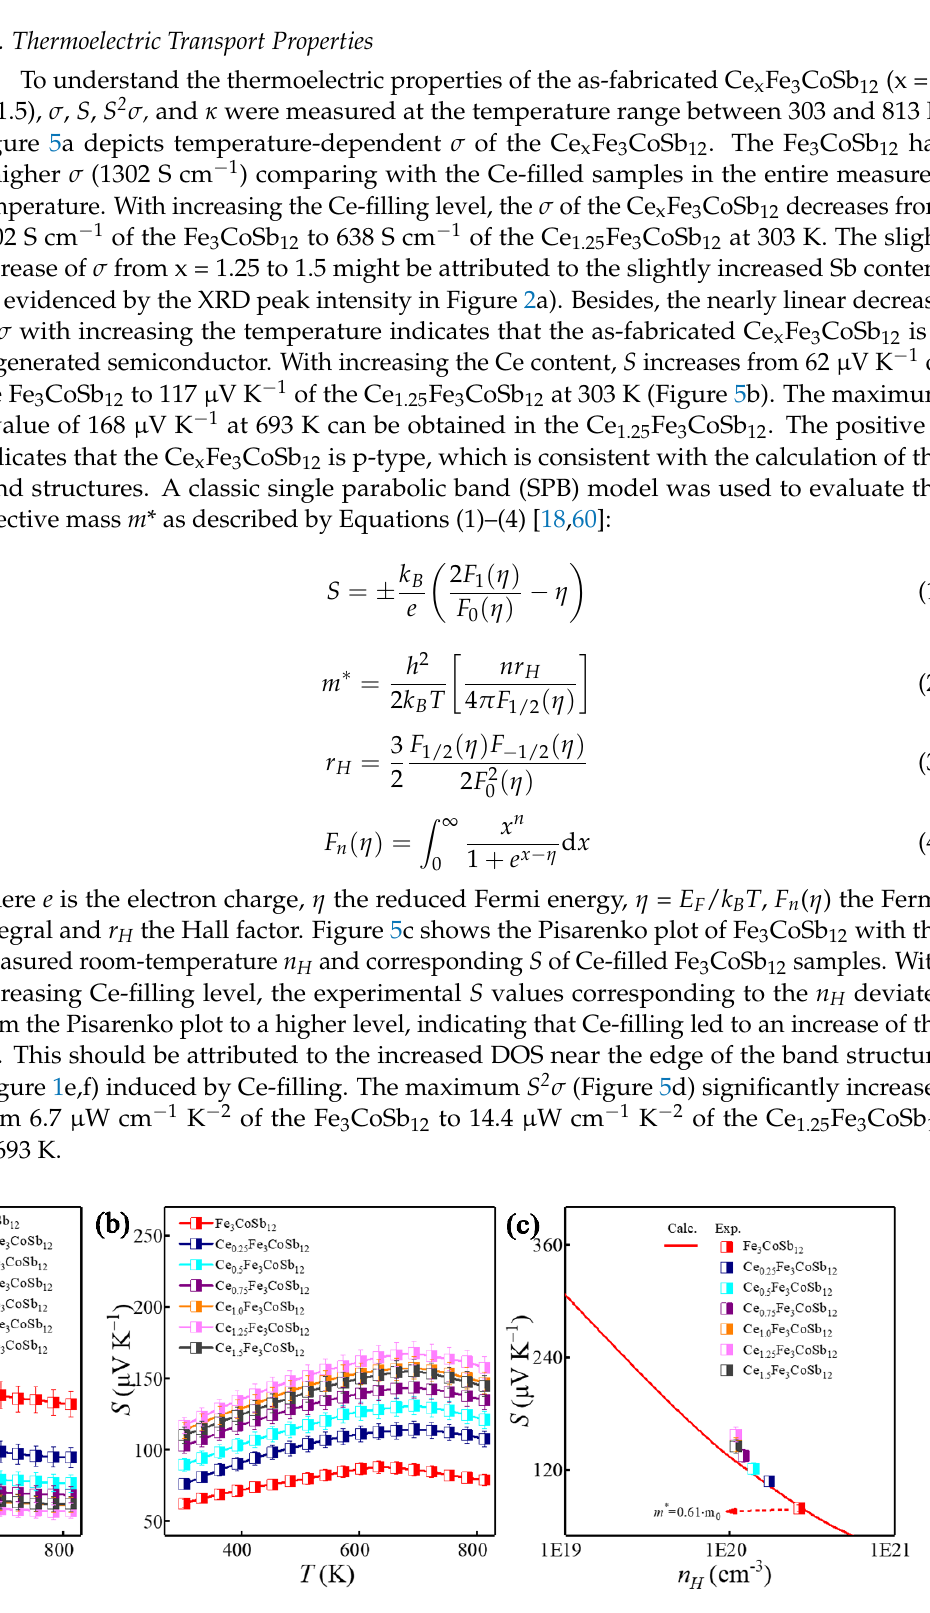
Figure 5. Thermoelectric properties of Ce x Fe 3 CoSb 12 (x = 0 to 1.5). Temperature-dependent ( a ) σ ; ( b ) S . ( c ) The experimental S values corresponding to the n H , where the red line represents the Pisarenko plot for Fe 3 CoSb 12 . Temperature-dependent ( d ) S 2 σ ; ( e ) κ ; ( f ) κ e ; ( g ) κ l ; ( h ) zT . ( i ) Comparison of the room-temperature κ for nominal Ce 1.25 Fe 3 CoSb 12 with the reported values for CeFe 2 Co 2 Sb 12 prepared by AM, [59] CeFe 4 Sb 12 [61] and Ce 0.6 Fe 3 CoSb 12 [62] prepared by TM, CeFe 3 CoSb 12 pre- pared by GS, [45] Ce 0.95 Fe 3 CoSb 12.1 prepared by SS, [46] and Ce 0.86 Fe 3 CoSb 12.09 prepared by melt spinning and spark plasma sintering (MS) [63]. Figure 5e plots temperature-dependent κ of the as-fabricated Ce x Fe 3 CoSb 12 (x = 0 to 1.5). With increasing the Ce-filling level, the κ gradually decreases and approaches 1.52 W m − 1 K − 1 of Ce 1.25 Fe 3 CoSb 12 at 693 K. The κ e can be calculated as κ e = L σ T (Figure 5f), where L is the Lorenz number calculated based on SPB model. With increasing the Ce-filling level, the κ e significantly reduces due to reduced σ . Figure 5g presents temperature-de- pendent κ l , calculated by κ - κ e . The κ l of the Ce-filled Fe 3 CoSb 12 is much lower than that of the unfilled Fe 3 CoSb 12 . The k l reduces with increasing the Ce-filling level and approaches a lowest κ l of 0.91 W m − 1 K − 1 at 693 K in the Ce 1.25 Fe 3 CoSb 12 . This should be primarily at-